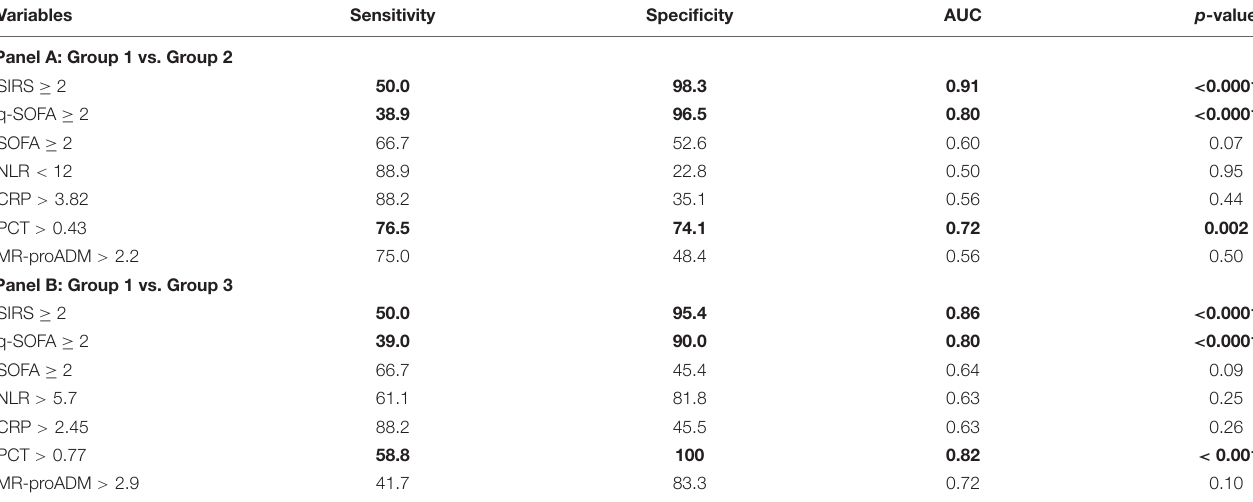
TABLE 4 | ROC curve analysis of SIRS, q-SOFA, SOFA scores, NLR, PCR, PCT, and MR-proADM comparing Group 1 vs. Group 2 (Panel A) and Group 1 vs. Group 3 (Panel B).